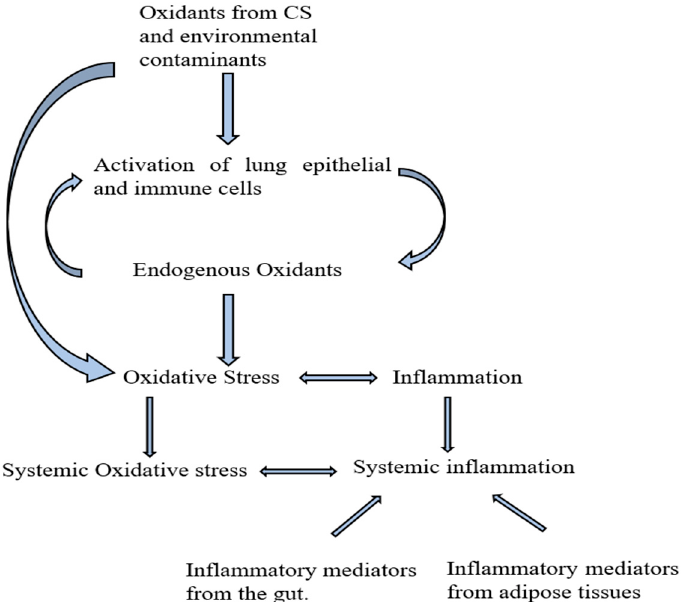
Figure 1. Sources of inflammatory mediators in COPD. CS: cigarette smoking. Oxidants from cigarette smoking and other environmental contaminants activate the lung epithelial and immune cells, leading to more oxidants from the immune cells, resulting in local oxidative stress. Oxidative stress initiates a series of activities that ultimately lead to local inflammation. The accumulated pro-inflammatory mediators in the lungs can leak into the blood, causing systemic inflammation. Pro-inflammatory mediators in COPD can also originate from the gut and adipose